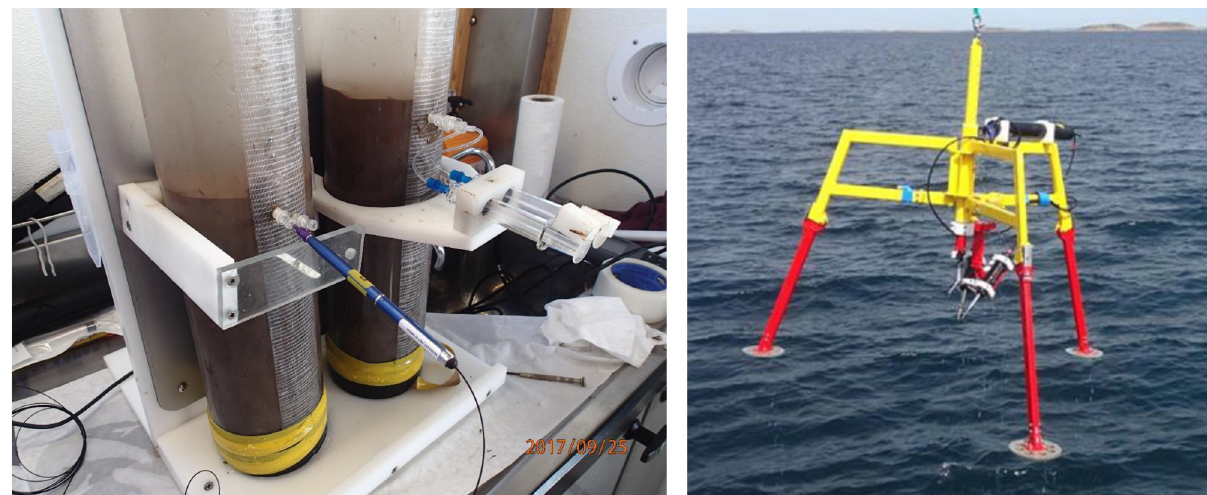
Fig. 1. Left: core sample processing at sea using RhizoCera porewater extractors attached to syringes (right core) followed by dissolved oxygen analysis of porewater using a needle-type fiber-optic microsensor (left core). Right: eddy correlation system being lowered to the